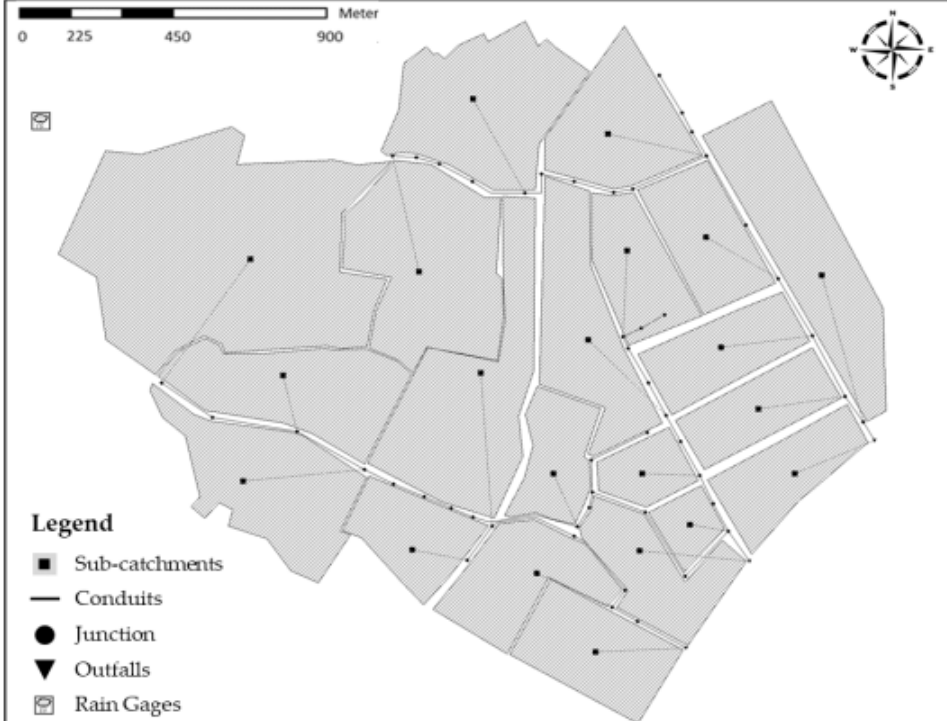
Figure 3. Establishment of the drainage system in the study